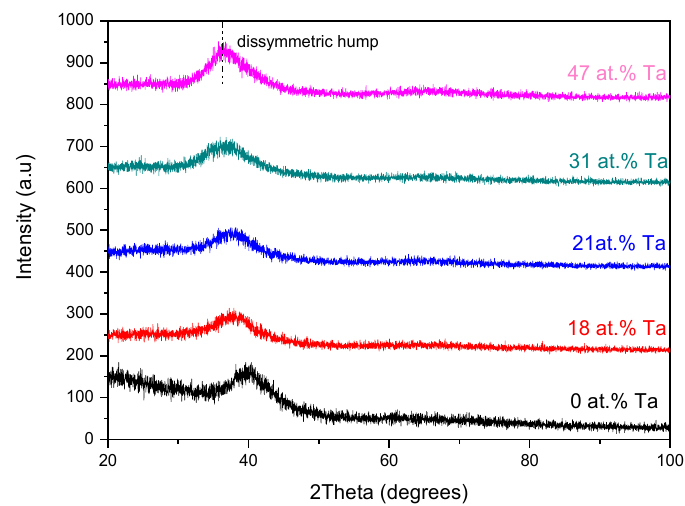
Figure 2. XRD diffractograms of as-deposited films as a function of Ta content. Dash line for the diffractogram of the film with 47 at % Ta highlights the dissymmetry of the hump.